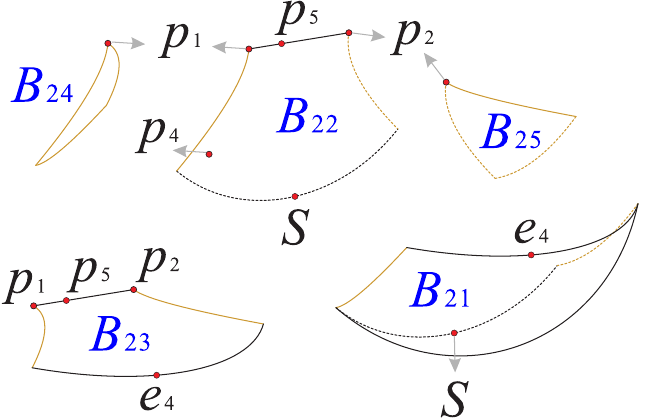
Figure 19. The three boundary surfaces and two boundary planes of the region R 2